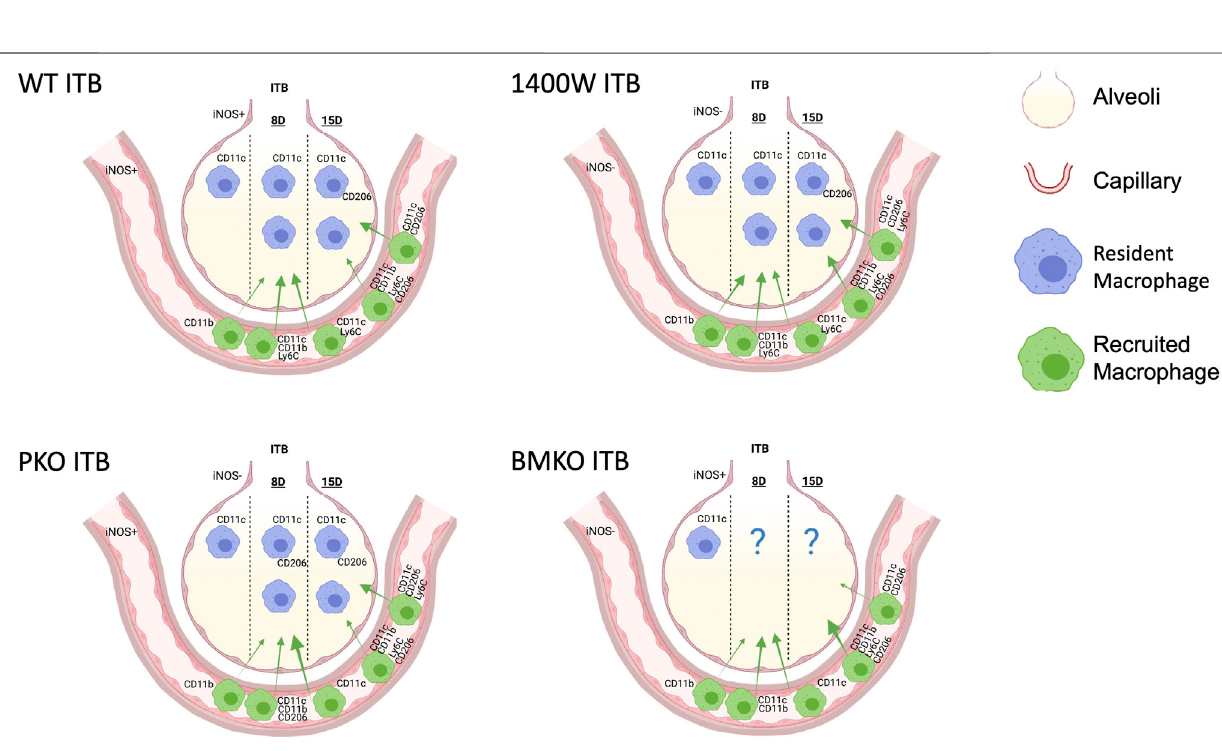
FIGURE 13 | A model to illustrate the macrophage populations 8 and 15 days following intratracheal instillation of bleomycin (ITB) in wild type mice, those treated with 1400 W, and iNOS chimeras. Macrophage populations vary in expression and relative distribution (demonstrated by arrow size) in response to iNOS competency. Created with